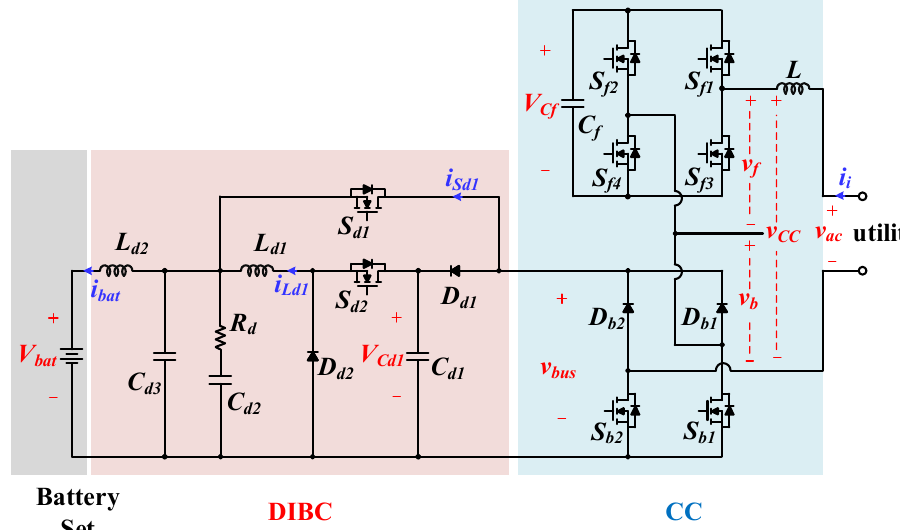
Figure 2. Power circuit of the proposed CADPCI.